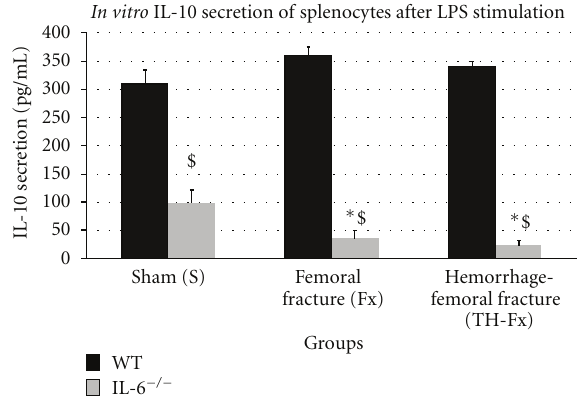
Figure 2: IL-6 productive capacity of splenocytes in response to their stimulation with LPS in wild-type (WT) and IL-6 knockout (IL-6 − / − ) mice in sham animals (group S), after an isolated femoral fracture (group Fx) and after the combination of a femoral fracture and hemorrhage (group TH-Fx). ∗ stat. significance ( P < 0 . 05) S vs. Fx and TH-Fx, # stat. significance ( P < 0 . 05) Fx versus. TH-Fx, $ stat. significance ( P < 0 . 05) WT versus. IL-6 − / − .